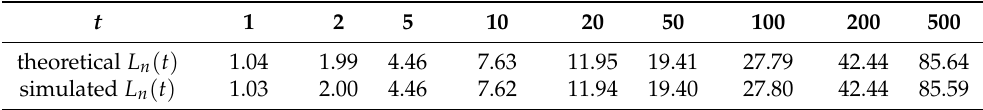
Table 3. Theoretical vs. simulated average number of losses in ( 0, t )